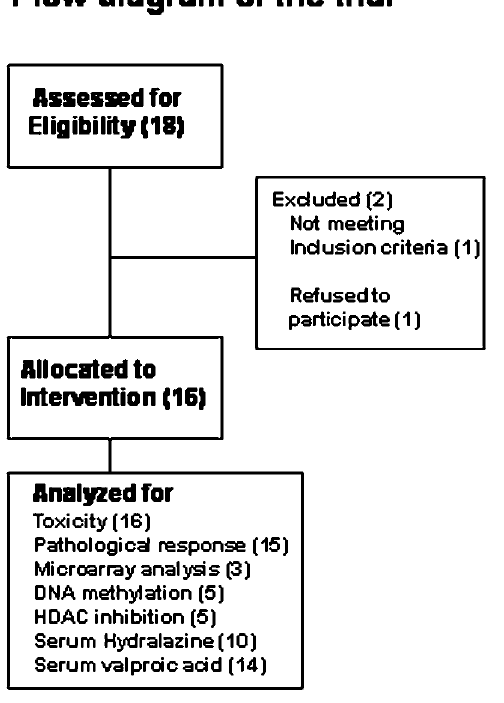
Figure 1. Flow diagram of the trial.